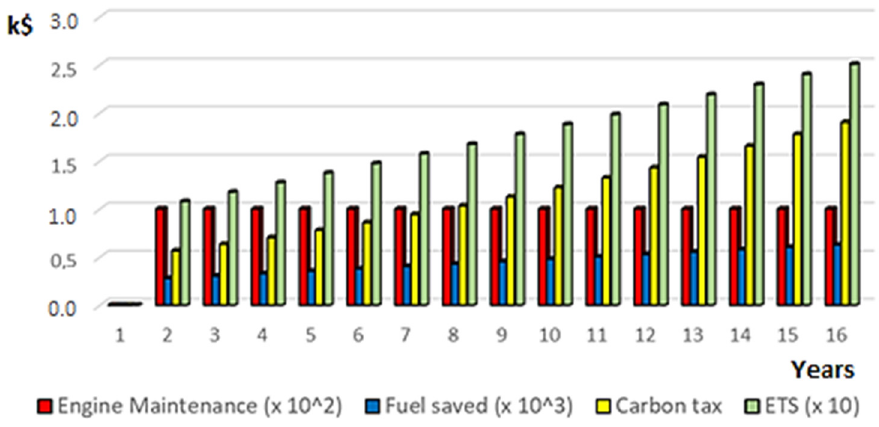
Figure 15. Savings estimation.